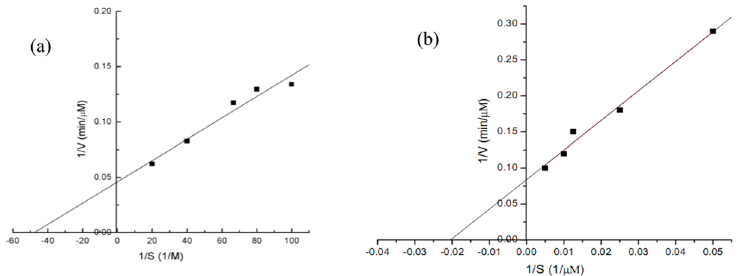
Fig 9. Determination of kinetic parameters of GDH-NOX. (a) Glycerol; (b) NADH. Experiment condition: glycerol concentration (0.01, 0.125, 0.014, 0.025, 0.05M), NADH concentration (20, 40, 60, 100, 200 μ M). pH 7.0,